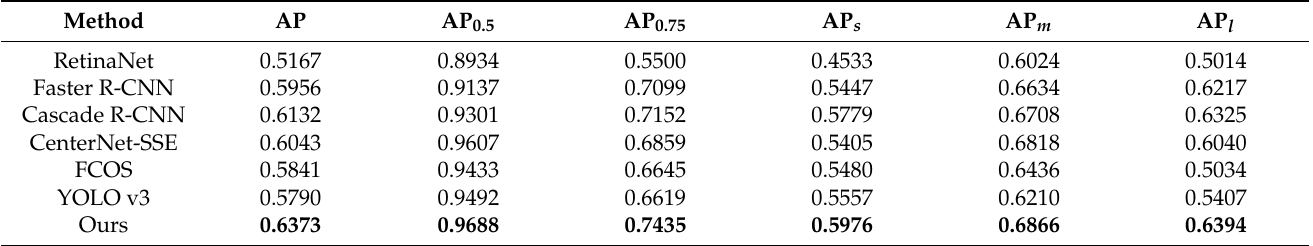
Table 9. Comparison results of CNN-based detectors on the SSDD dataset on various AP metrics.